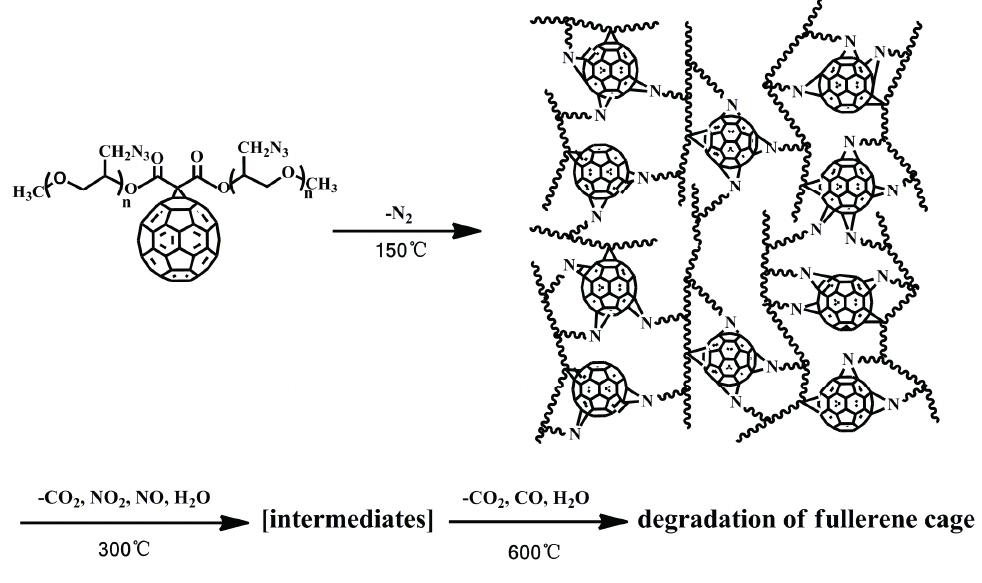
Scheme 2. Thermal decomposition mechanism of C 60 -GAP under air